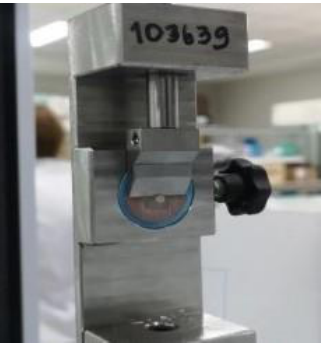
Figure 1 . Test setup for shear bond strength . Figure 1. Test setup for shear bond